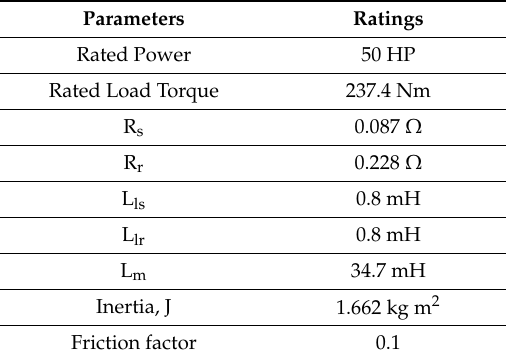
Table 1. Model parameters.